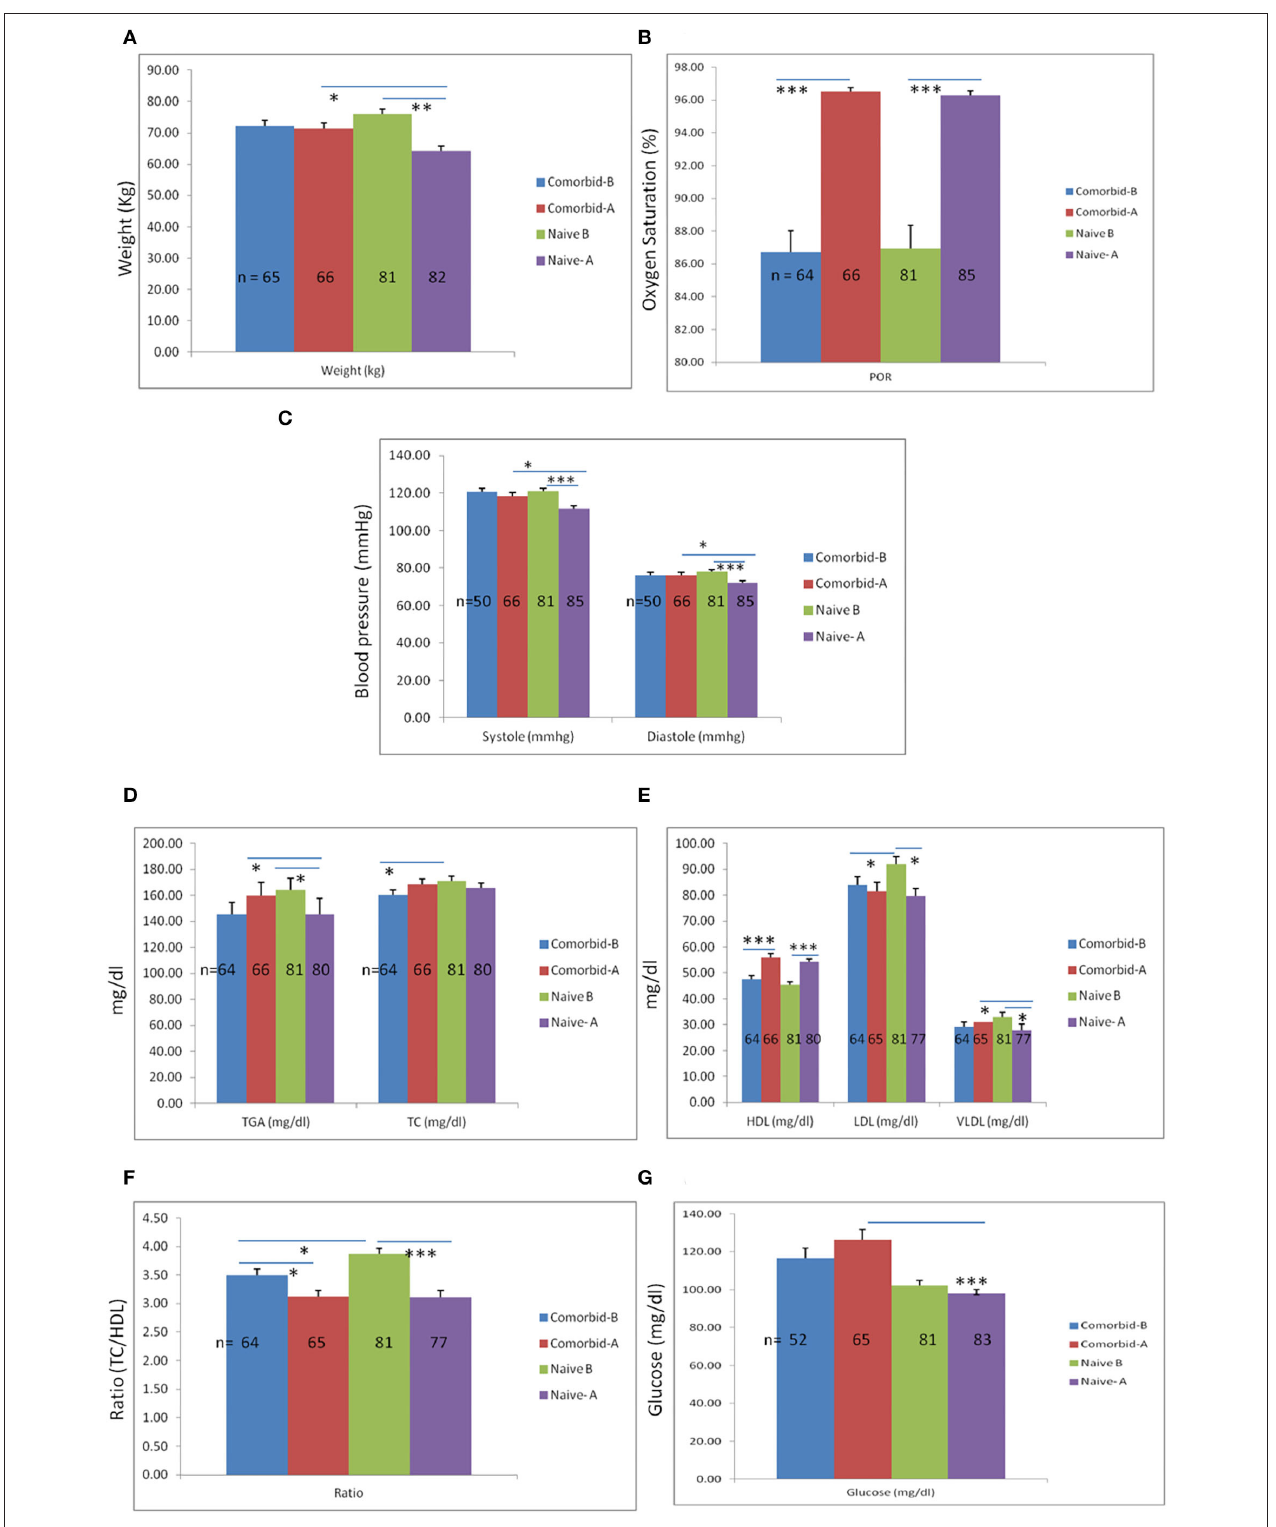
FIGURE 4 | Comparison of physiological-biochemical parameters between comorbid and naïve participants. A month of yoga practice in both groups has demonstrated a significant weight reduction. (A) However, weight reduction was significantly more in the naïve group as compared to the comorbid group. Additionally, significant reductions in blood pressure (systolic and diastolic) were observed in the naïve group after a 1-month yogic practice, although reductions